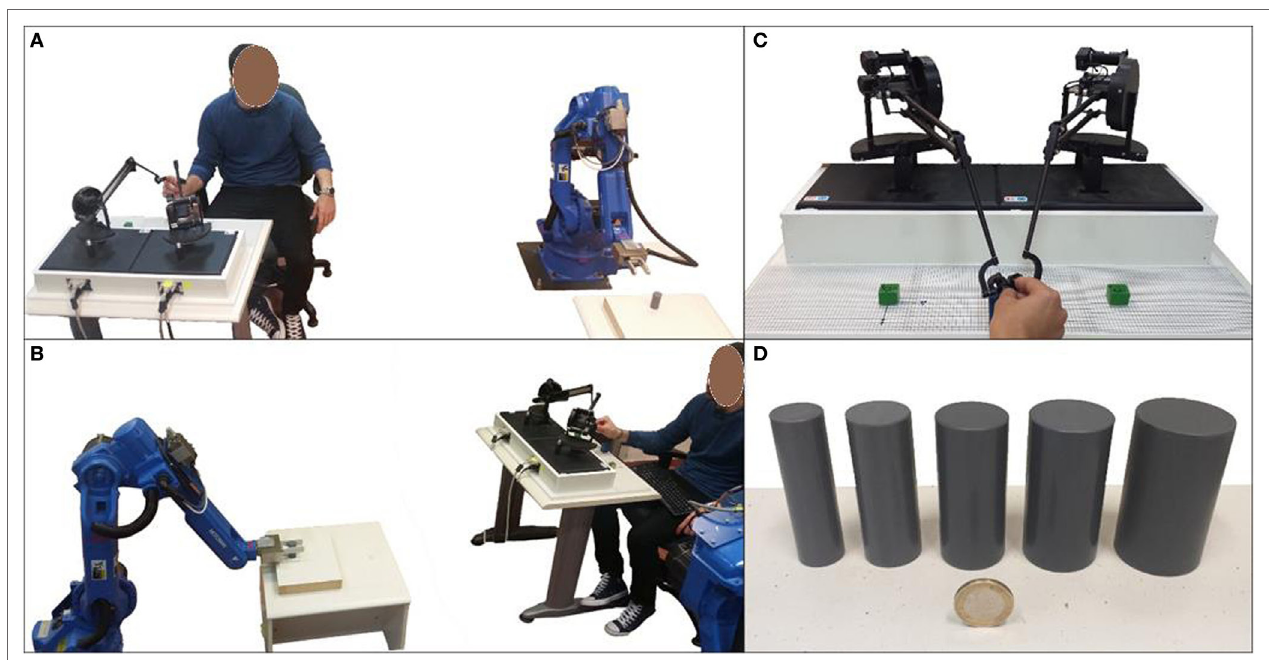
FigUre 1 | Experimental setup. (a) Alongside, (B) across, (c) initial position, (D) tested cylinders. Written and informed consent has been obtained from the depicted individual for the publication of his identifiable